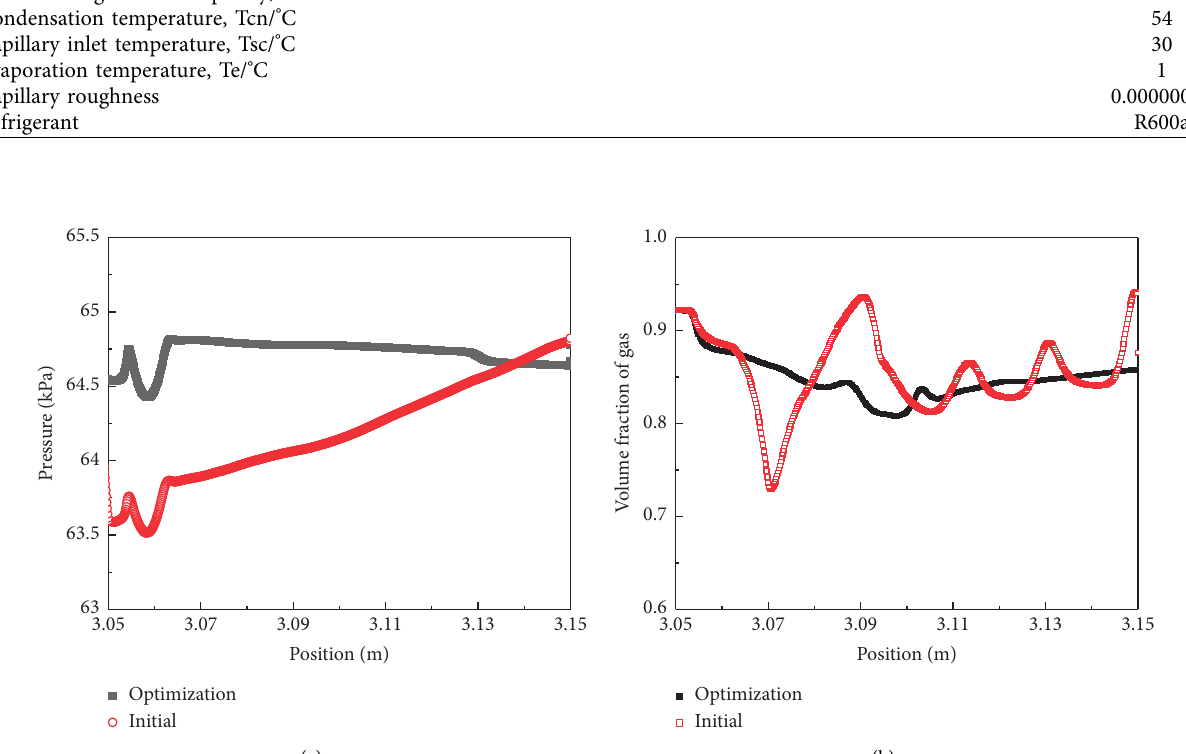
Figure 4: Local pressure and liquid-phase volume fraction at the transition pipe. (a) Local pressure at the transition pipe. (b) Gas-phase volume fraction at the transition